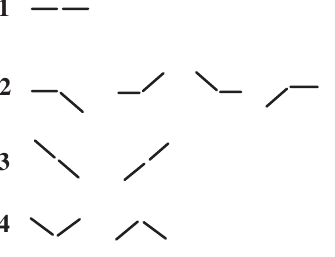
Figure 2. Types of Gray-Level Graphical Structure Variations and Corresponding Gray-Level Class Numbers (1–4). Table 1. Mapping from Gray-Level Numbers (1–4) to Initial Class Numbers